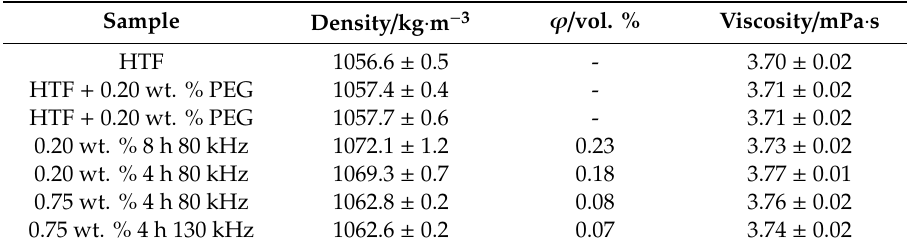
Table 3. Density, volume fraction and viscosity values of heat transfer fluid (HTF) and 2D-WS 2 -based nanofluids at 25 °C.